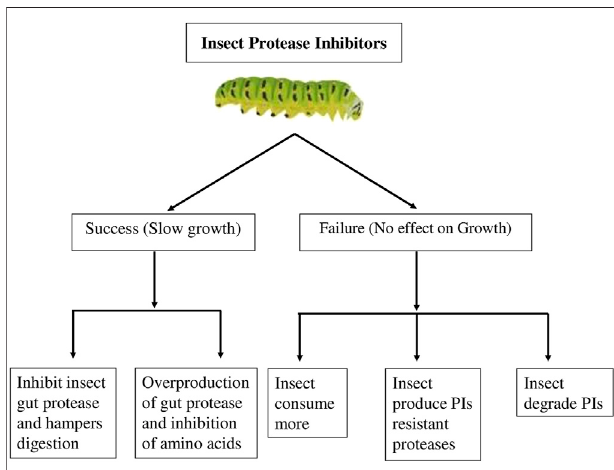
FIGURE 3 | Impact of protease inhibitors (PIs) on insect pest